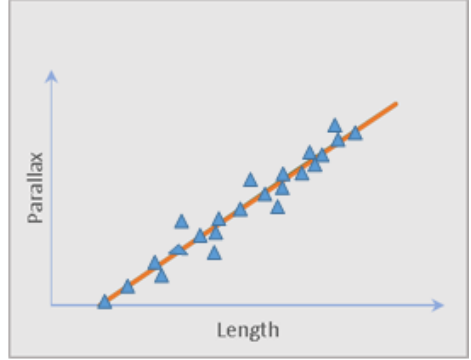
Fig. 1 Ideal parallax and line segment length